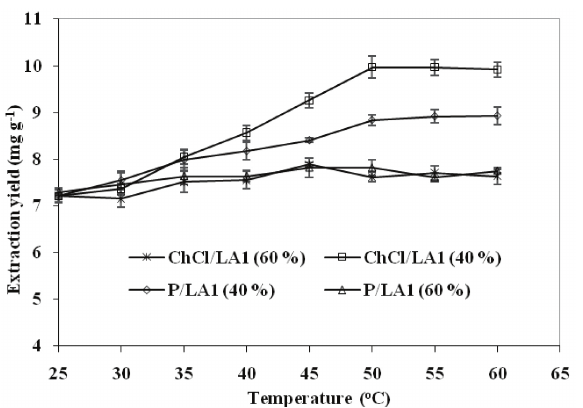
Fig. 2 – Effect of temperature on the extraction yield of Ginkgo flavonoids. ChCl/LA1 and P/LA1 containing 40 % or 60 % (w/w) water were used as extraction solvents at a solvent to solid ratio of 15:1 with stirring at varied temperatures and 150 rpm for 10 min.